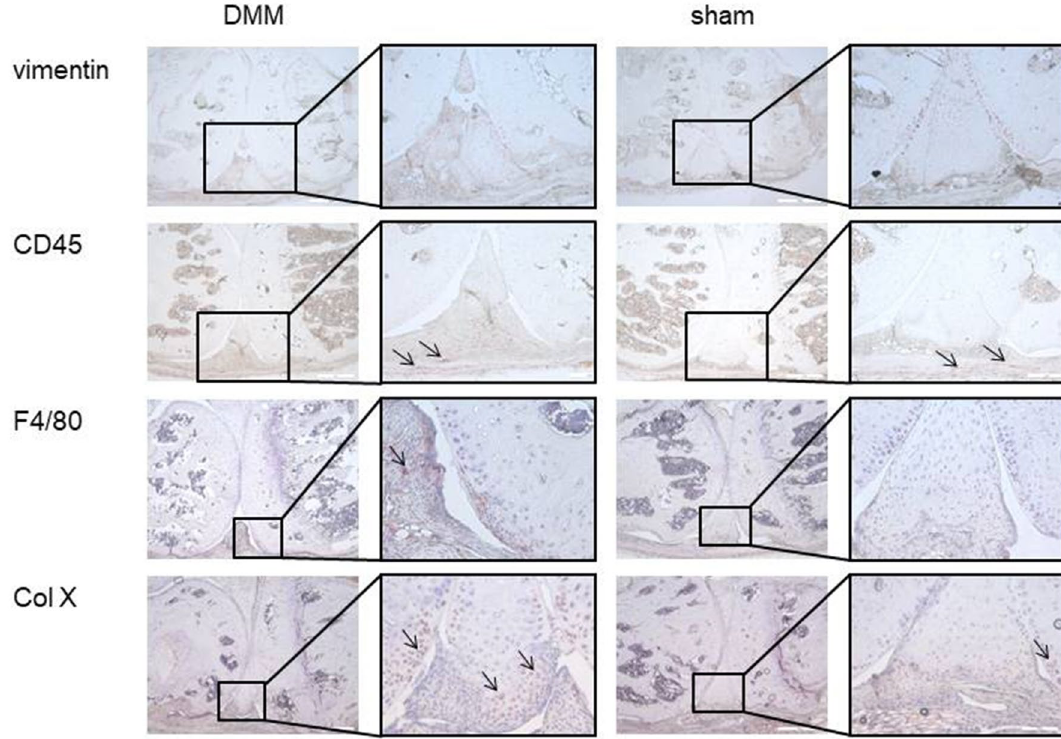
Figure 4. Local adipokine distribution in DMM vs. sham-treated legs. ( a ) All adipokines were present in the bone marrow in sham-treated and DMM legs. Cells invading the damaged menisci in DMM expressed adiponectin as well as leptin (arrows) independent on the diet. Hypertrophic but not proliferative chondrocytes in the epiphyseal growth plate expressed visfatin (4 weeks: ND h (healthy) n = 3, ND DMM n = 10, HFD h n = 3, HFD DMM n = 10; 6 weeks: ND h n = 3, ND DMM n = 10, HFD h n = 3, HFD DMM n = 7; 8 weeks: ND h n = 4, ND DMM n = 10, HFD h n = 4, HFD DMM n = 10). ( b ) Quantification of adipokine-positive cells in the meniscus revealed an increased number of adipokine positive cells in the DMM groups compared to the healthy groups but no differences between HFD vs. ND in the DMM group could be observed. Ages 4, 6, 8 weeks were pooled for each group (adiponectin 4 weeks: ND h n = 4, ND DMM n = 6, HFD h n = 5, HFD DMM n = 5; 6 weeks: ND h n = 5, ND DMM n = 7, HFD h n = 5, HFD DMM n = 2; 8 weeks: ND h n = 1, ND DMM n = 8, HFD h n = 4, HFD DMM n = 10; sham adiponectin ND n = 29, HFD n = 18. Leptin 4 weeks: ND h n = 4, ND DMM n = 3, HFD h n = 5, HFD DMM n = 3; 6 weeks: ND h n = 5, ND DMM n = 5, HFD h n = 4, HFD DMM